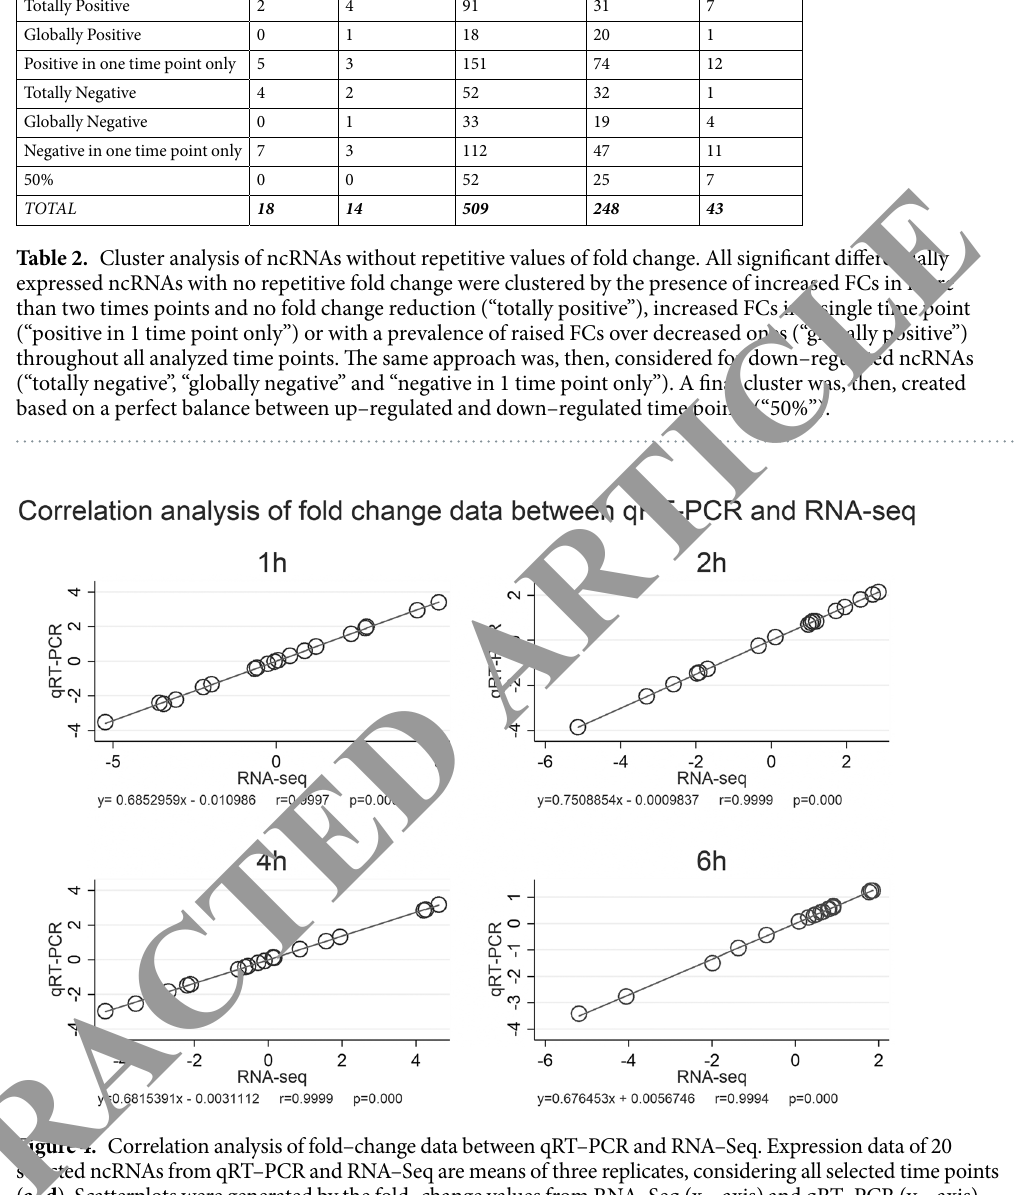
Figure 4. Correlation analysis of fold–change data between qRT–PCR and RNA–Seq. Expression data of 20 selected ncRNAs from qRT–PCR and RNA–Seq are means of three replicates, considering all selected time points ( a – d ). Scatterplots were generated by the fold–change values from RNA–Seq (x – axis) and qRT–PCR (y –